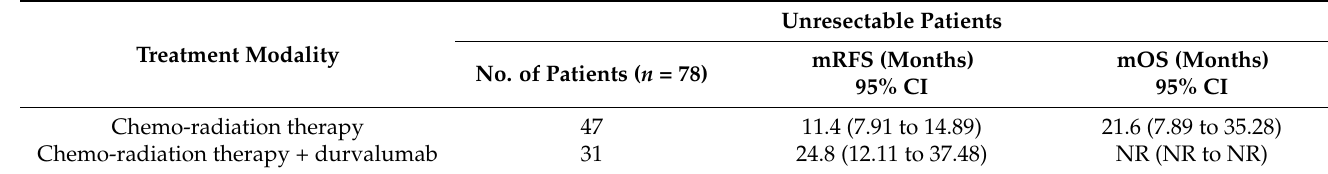
Figure 17. Kaplan–Meier curves of estimated overall survival in the entire population who underwent definitive chemo-radiation therapy according to treatment pathway. CT-RT, chemo-radiation therapy. Table 6. Survival outcomes as per the chemo-radiation treatment pattern.